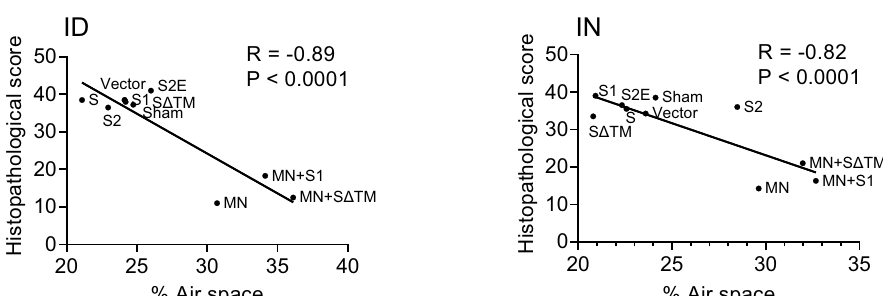
Fig. 5 Percent alveolar air space and correlation between lung histopathological score and percent alveolar air space. a Percent alveolar air space was quantitated as described in “ Methods ” at Day 7 post 10 5 CFU SARS-CoV-2 intranasal challenge in lungs of hamsters immunized ID (left) or IN (right) with the indicated vaccines. b Percent alveolar air space vs. Sham (PBS) [(Air space of immunized animal − Mean air space of Sham)/Mean air space of Sham]. a , b Shown are means + SE. Animals immunized with PBS (Sham), LVS Δ capB (Vector), the S vaccines (S, S Δ TM, S1, S2, and S2E), and the MN vaccines (MN, MN + S Δ TM, and MN + S1) were compared by ANOVA (JMP 15.0); * P < 0.05; *** P < 0.001; and **** P < 0.0001. c Correlation between mean lung (cranial and caudal) histopathological score and mean percent alveolar air space for ID (left) and IN (right) vaccination route (Prism 9.0.0). In addition, the correlation between lung histopathological score and mean percent alveolar air space for individual animals is R = − 0.74 ( P < 0.0001) (ID) and R = − 0.80 ( P < 0.0002) (IN) (JMP